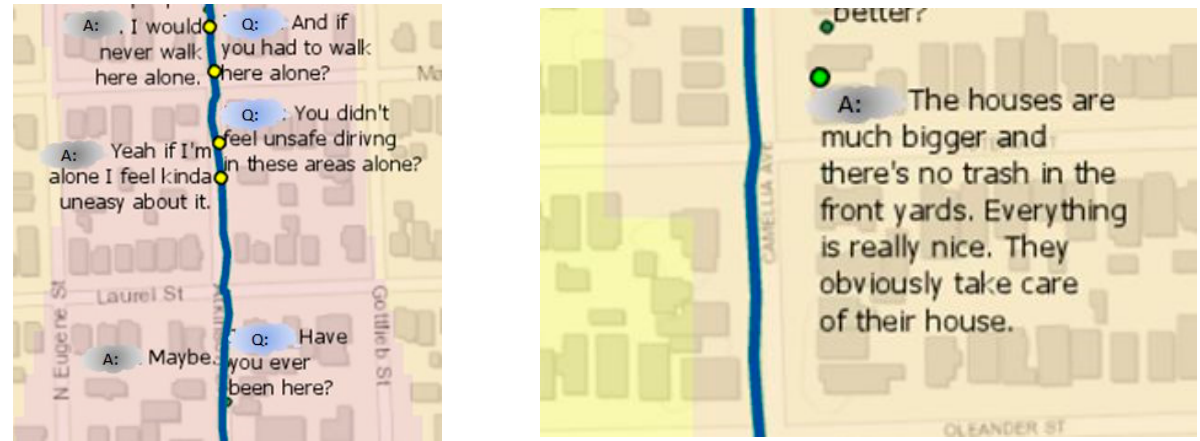
Figure 10. Example of mapping a portion of a geonarrative’s transcript applying Wordmapper (Ajayakumar, Curtis et al. 2019).